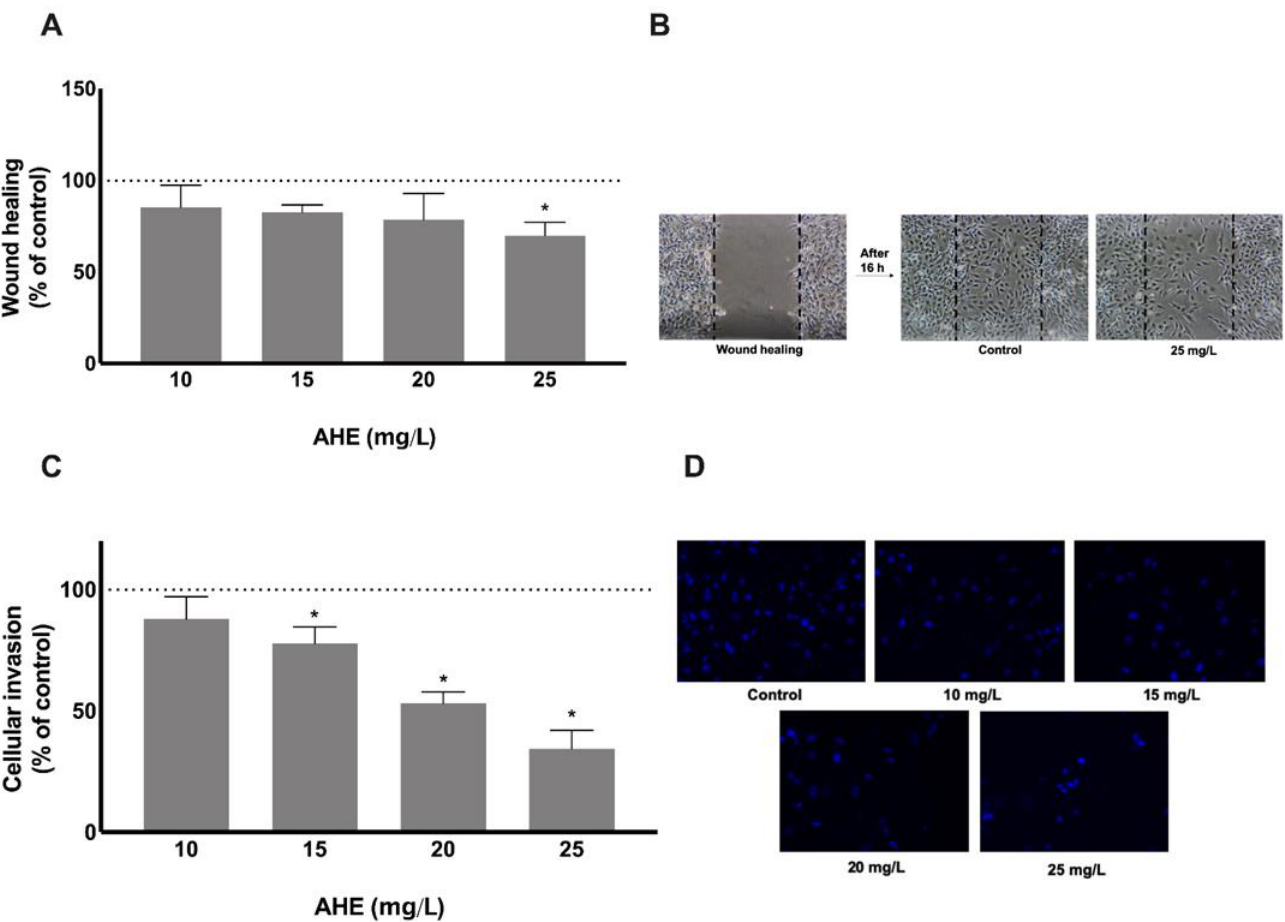
Figure 3. The ability to impair HMEC-1 migration and invasion was performed after 16 h and 24 h treatment with AHE by injury assay ( A , B ) and matrigel-coated transwell assay ( C , D ), respectively. There is an abrogation in cell motility and the capacity to migrate to the wound area was reduced at a concentration of 25 mg/L ( A ). Dotted lines represent the wound healing area at the beginning of experiment ( B ). HMEC-1 invasive capacity through a matrigel membrane was reduced in a dose-dependent manner with significance for doses of 15 mg/L or higher ( C ). Representative images of invasive HMEC-1 under fluorescence microscope ( D ). Results are presented as % of control group mean ± SD. * p < 0.05 vs. control.